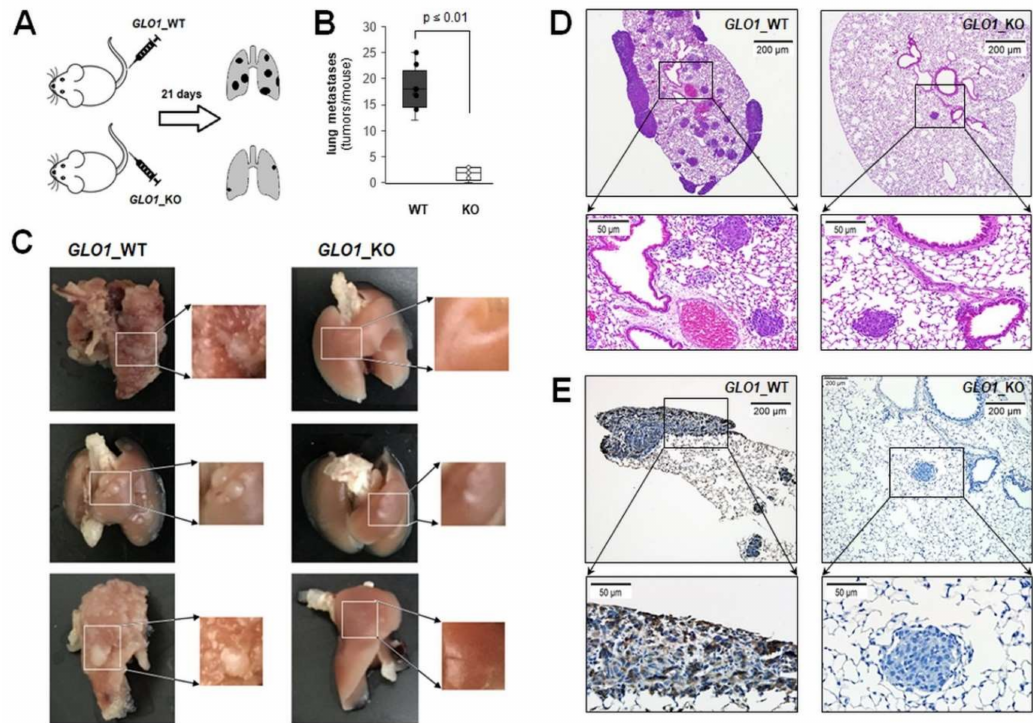
Figure 5. Genomic GLO1 deletion impairs metastasis in a SCID mouse model of malignant melanoma. ( A ) Melanoma cells (WT, B40_KO) were tail vein injected (five mice per group) followed by analysis of lung metastasis 21 d later. ( B ) Box plot depicts numeric analysis of metastases per lung. ( C ) Total lung specimens were obtained upon harvest [with field magnification (right panel) for visualization and counting of metastases]; left panels: GLO1_WT; right panel: GLO1_KO. ( D ) Representative lung tissue cross sections were visualized by H&E staining or ( E ) GLO1 immunostaining, absent from GLO1_KO tumor tissue [taken at 4 × (top) versus 20 × (bottom)